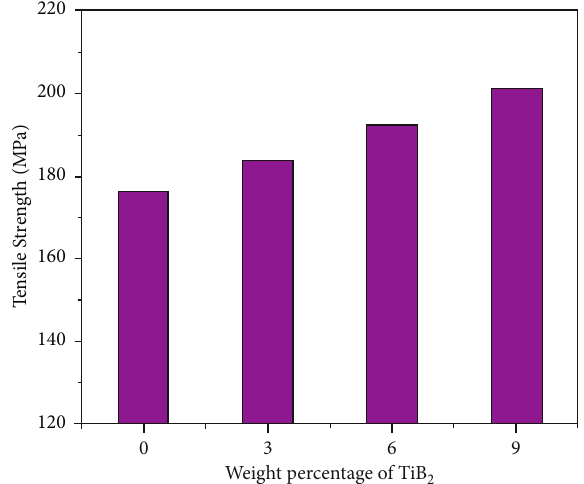
Figure 6: Influence of tensile strength on the wt% of TiB